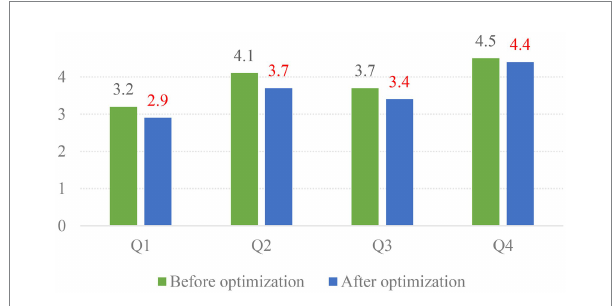
FIGURE 4 The economy cost effect before and after the model optimization.